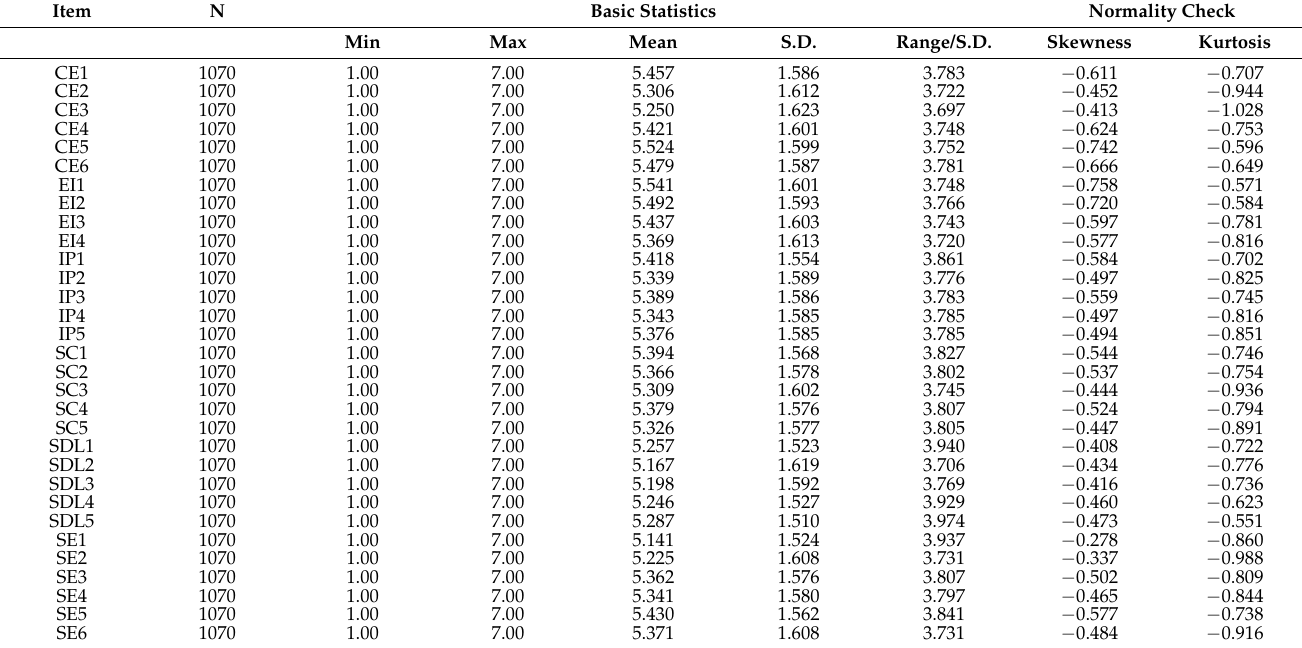
Table 2. Descriptive